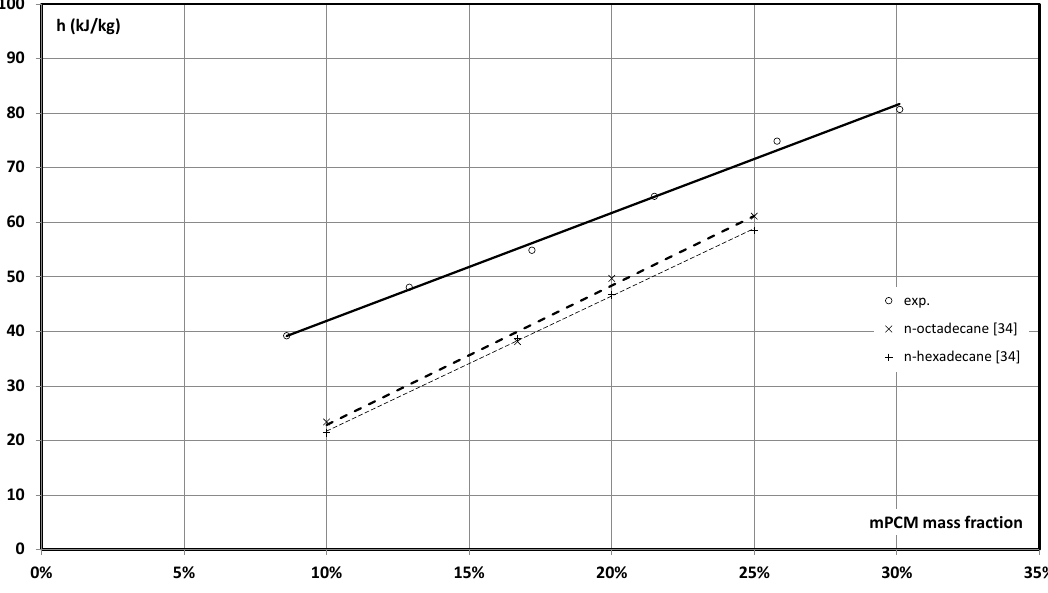
Figure 5. Influence of PCM mass fraction on phase change heat of mPCM slurry.